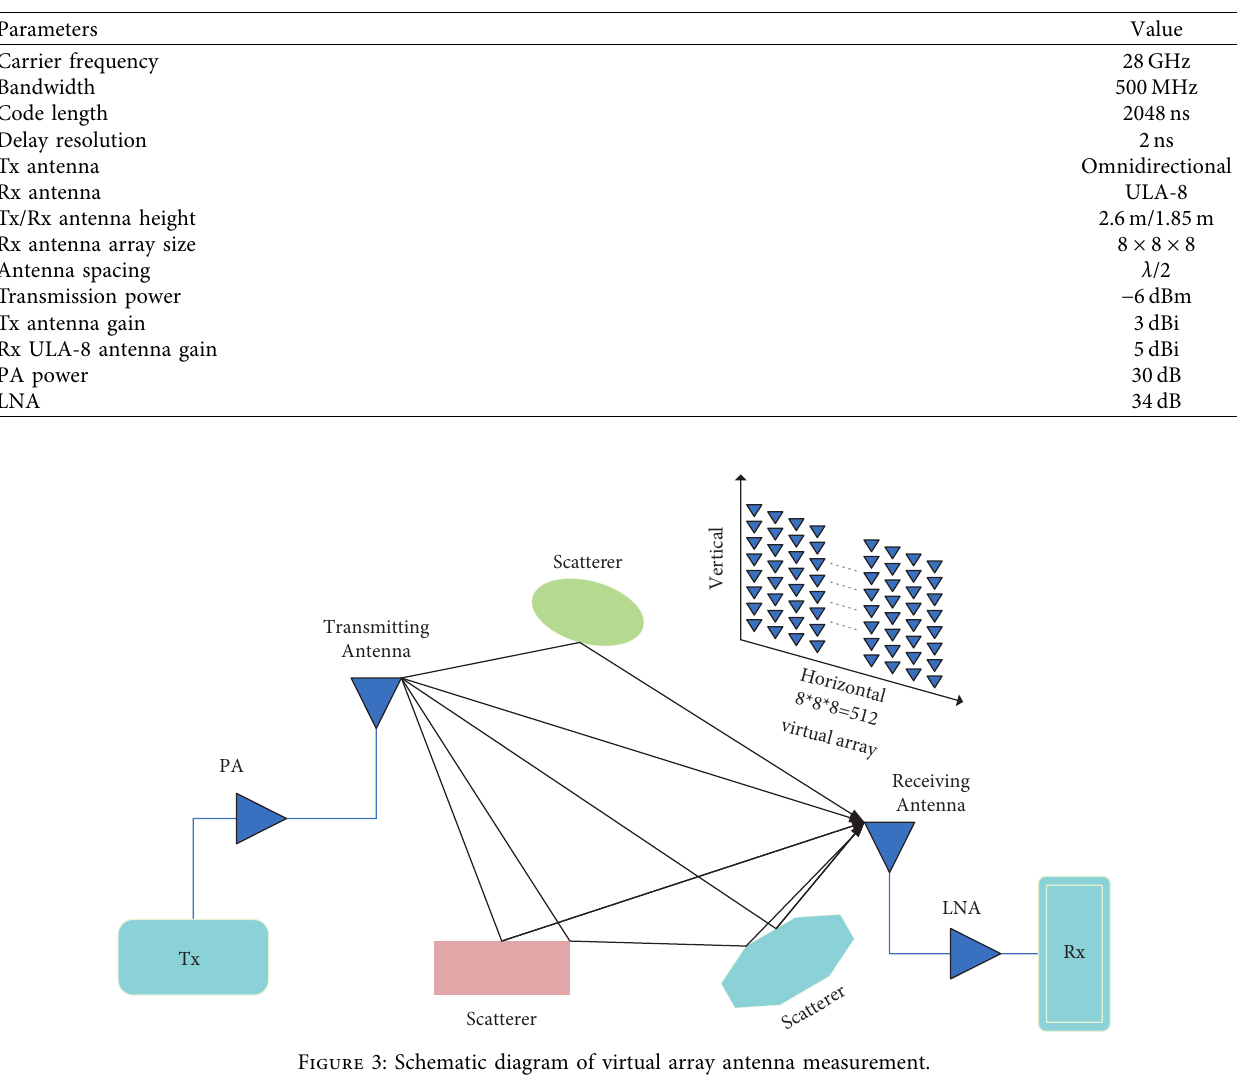
Table 1: Parameters for channel sounding system.